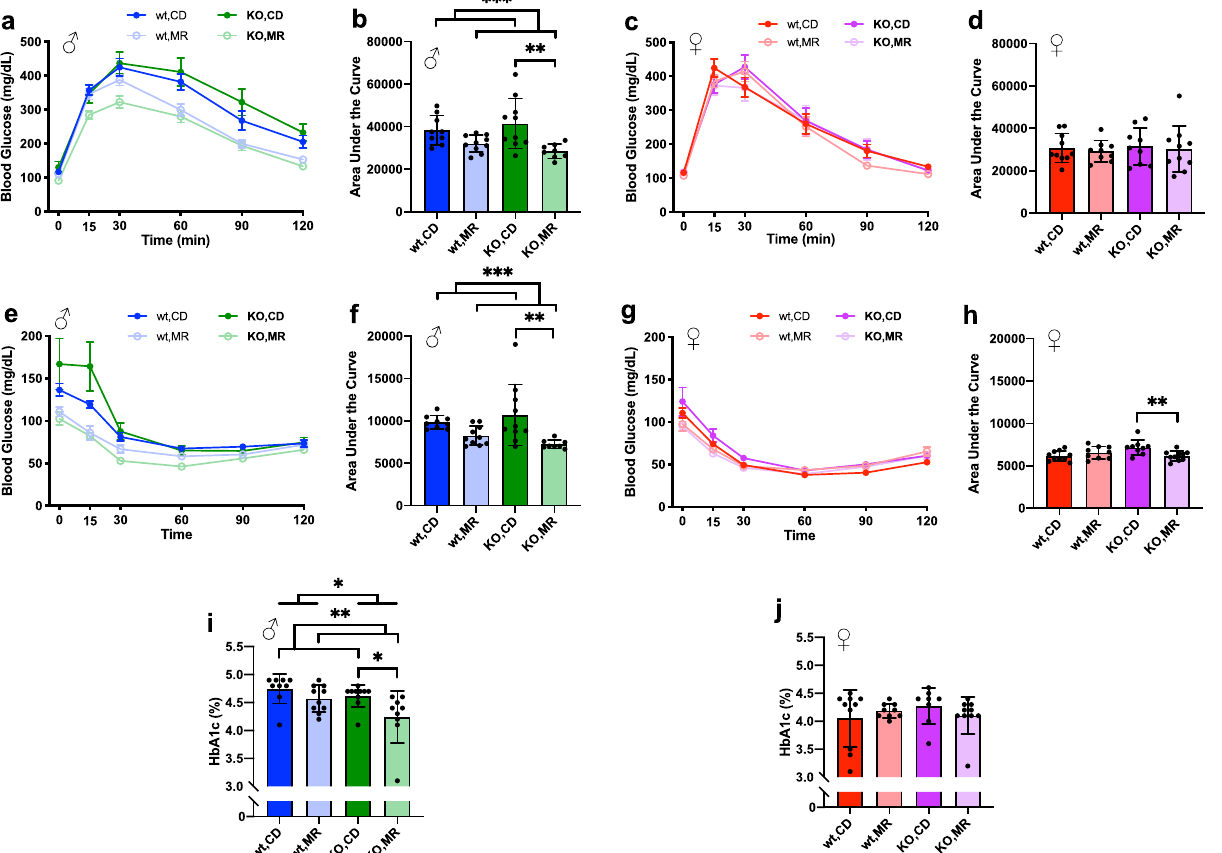
Figure 3. Males have greater glucose metabolism response to MR than females. Glucose Tolerance Test curves ( a ), ( c ) and Area Under the Curve (AUC) for their respective curves ( b ), ( d ) for both sexes. Insulin Tolerance Test curves ( e ), ( g ) and AUC for their respective curves ( f ), ( h ). AUC calculated by the trapezoid method and analyzed within each sex via Two-Way ANOVA for main effects. Post-hoc analysis was performed with Sidac multiple comparisons correction to assess the diet effect within each genotype. HbA1c was analyzed similarly ( i ), ( j ). Line graphs represent means ± s.e.m., bar graphs represent means ± s.d.. Groups were 8–10 mice. (* p < 0.05; ** p < 0.01; *** p <